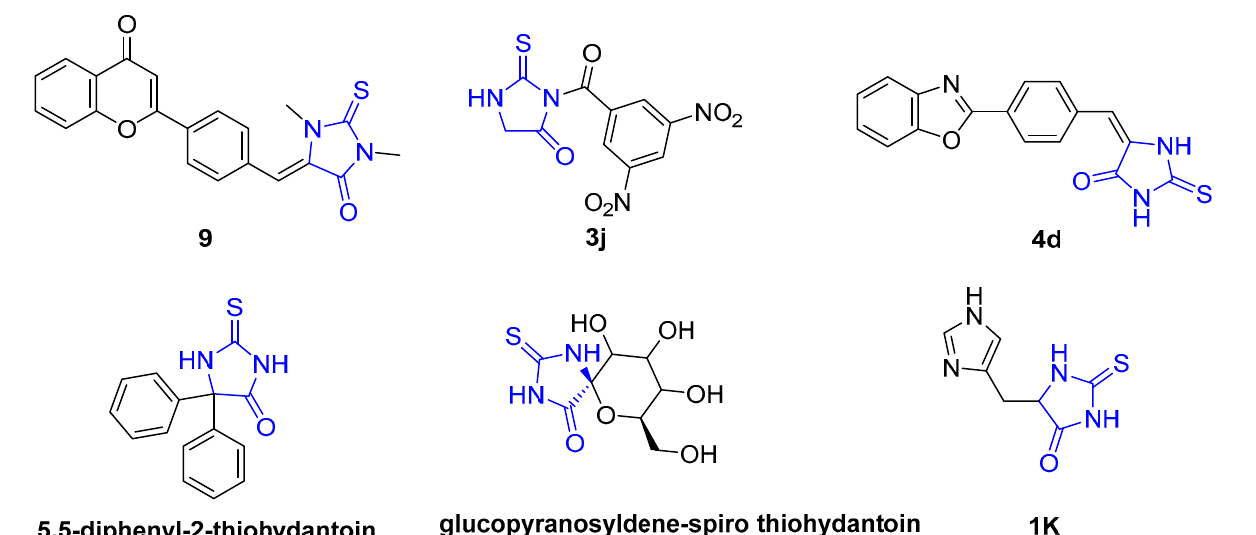
Figure 1. Representative structures of 2-thioxoimidazolidin-4-one analogues with potential antioxidant and antidiabetic activities.